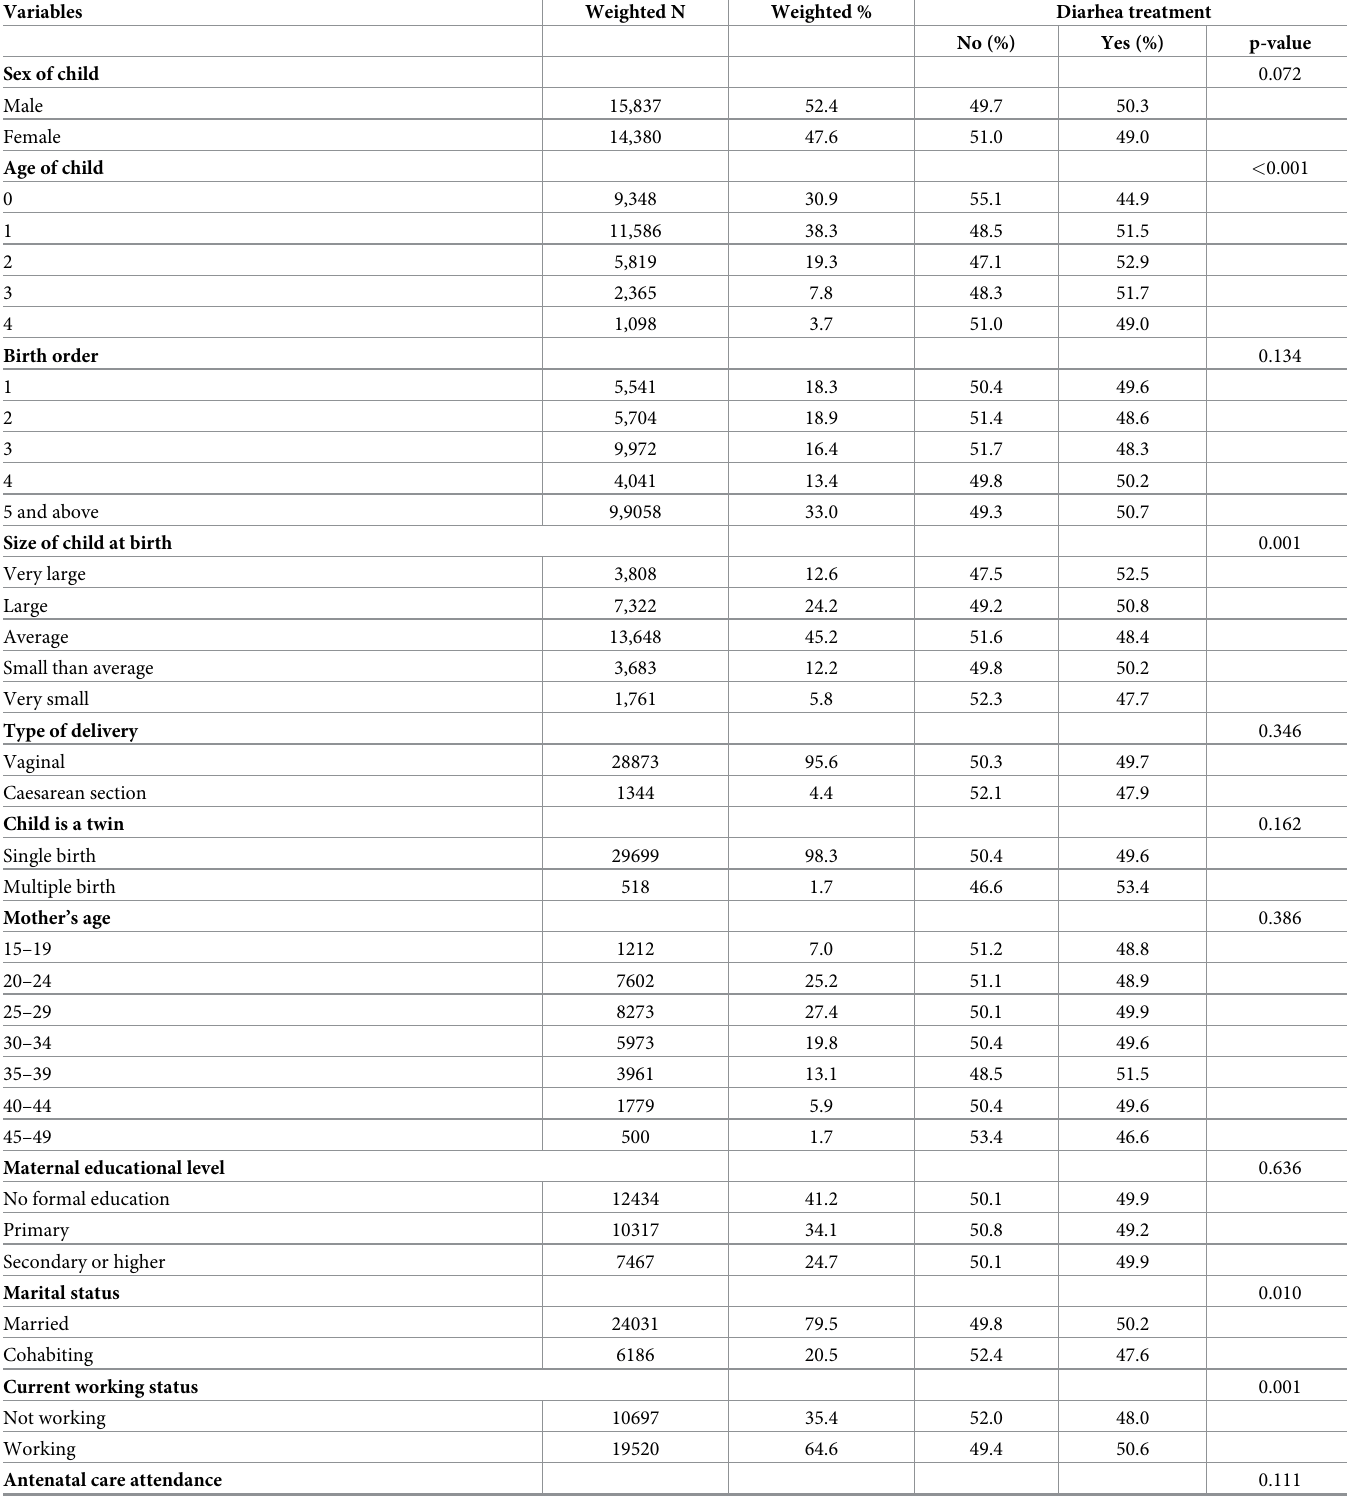
Table 2. Distribution of diarrhoea treatment across the explanatory